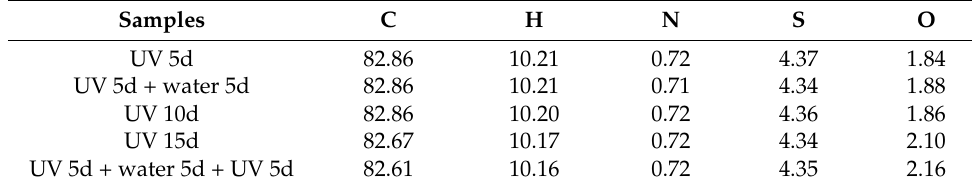
Table 6. Element content of asphalt after the aging cycle of UV and water (%).